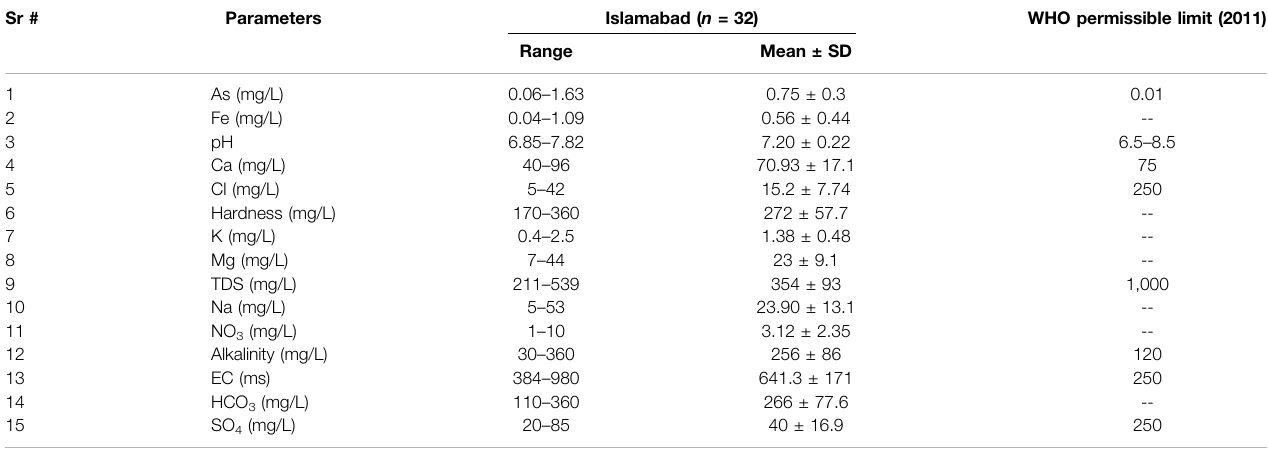
TABLE 3 | Concentrations of water parameters in fi ltration plants.